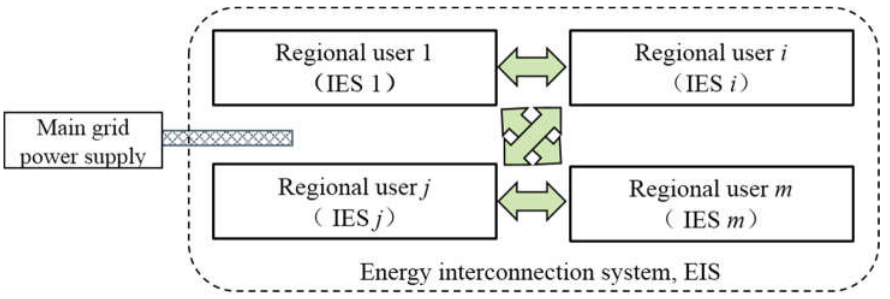
Figure 6. A regional distributed energy interconnection network.